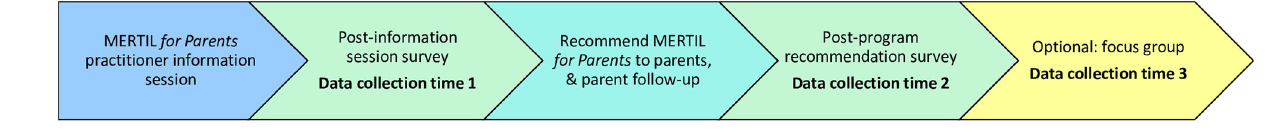
Fig 4. Flow diagram of MERTIL for Parents professional data collection timeline.